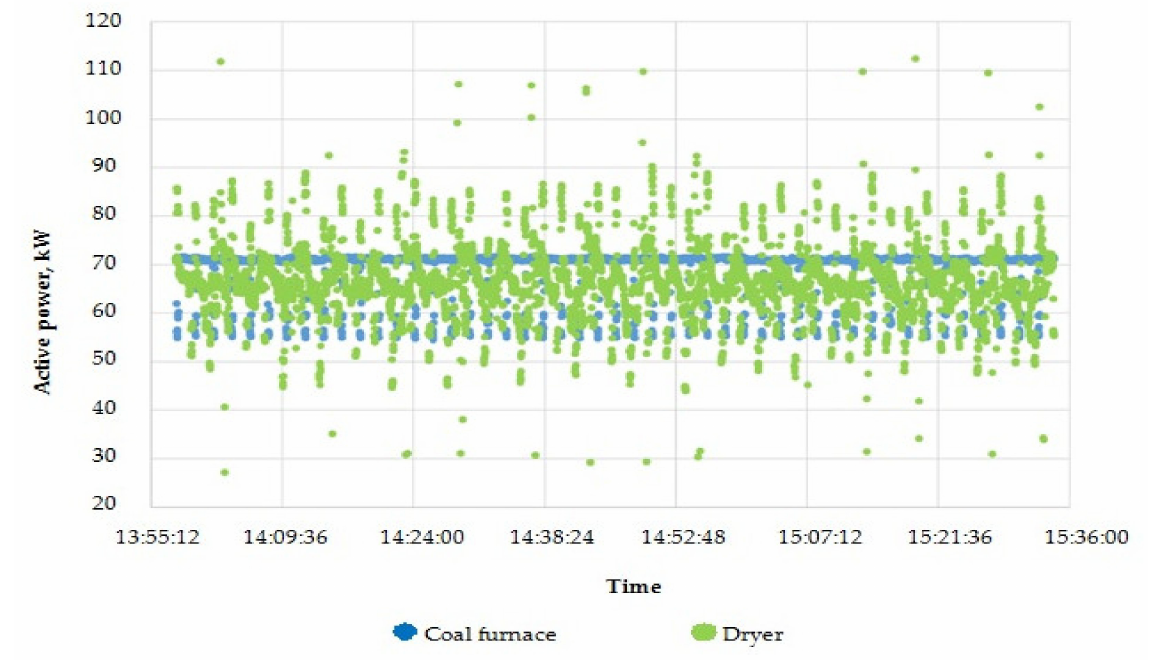
Figure 3. The active power curve of the DT2532 dryer.